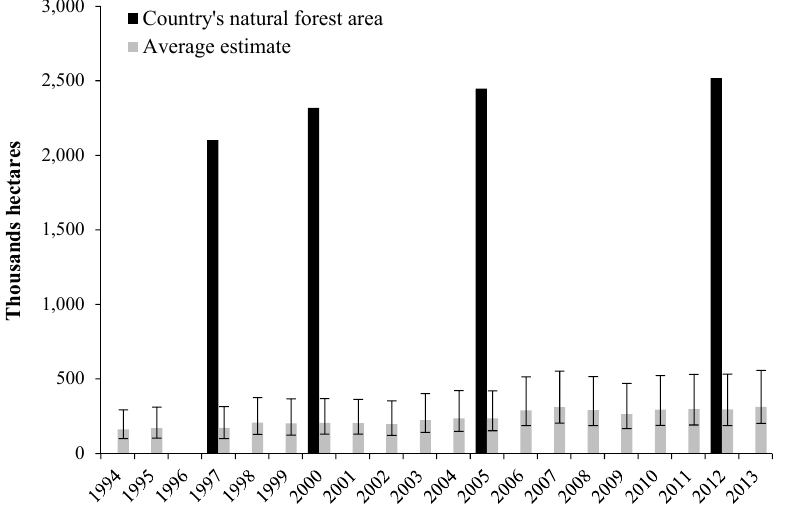
Figure 5. Estimates of the area of natural forest that would have been required annually to meet the total wood demand of the pallets industry in Costa Rica over 1994–2013, compared to the actual country’s area of natural forest. Grey bars represent our best guess estimates, based on a productivity of 1 m³/ha/yr, an average requirement of sawnwood by pallet of 0.034 m³, and a sawing efficiency of 60%. Errors bars are associated to the ranges of forest productivity (1 – 1.3 m³/ha/yr), sawnwood requirement (0.03-0.04 m³/pallet), and sawing efficiency (50% – 70%). The growing export of commodities resulted in an increasing demand for both agricultural and forest land. Bananas, pineapples, melons, palm oil and cassava were the main export-oriented products that were exported on pallets and whose cultivation area expanded between 1985 and 2013.